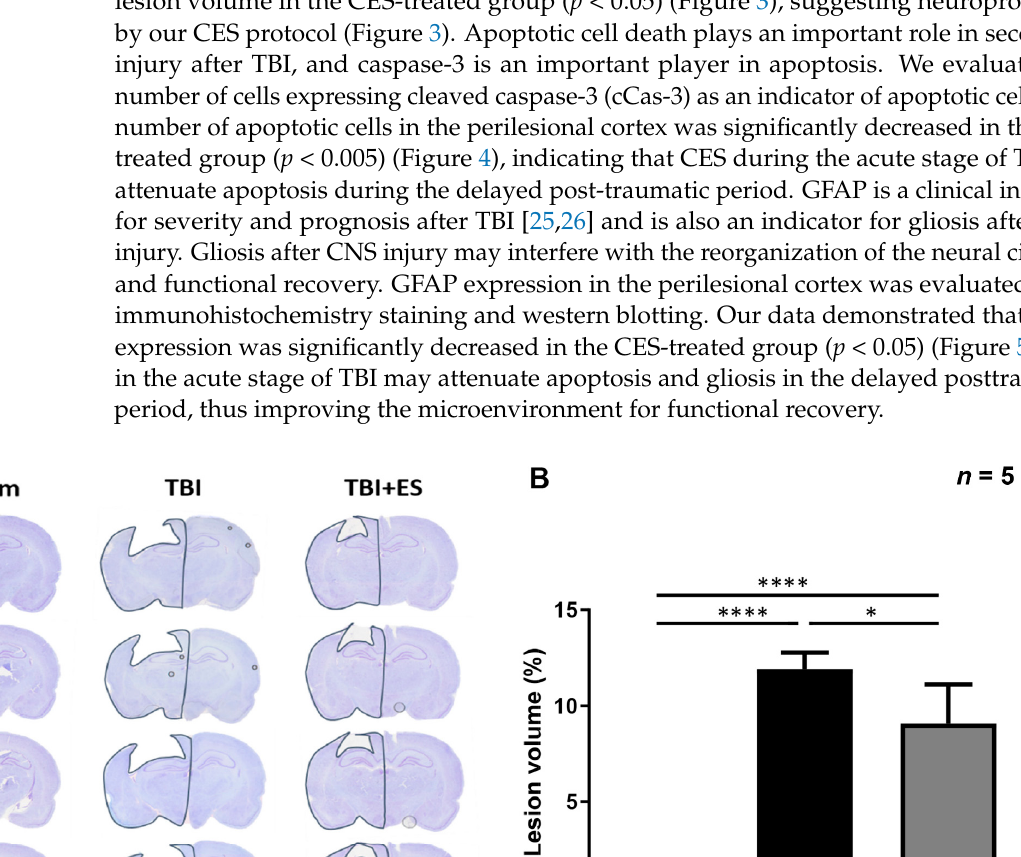
Figure 4. CES reduced cleaved caspase 3 (cCas-3) immunoreactive cells in the perilesional cortex. ( A ) Representative picture illustrating the sample region for the perilesional cortex. The cortical specimen was obtained within 1 mm from the wall of the lesion cavity. ( B , C ) Representative pictures of immunofluorescent for cCas-3 (green). ( D , E ) Representative pictures of merged